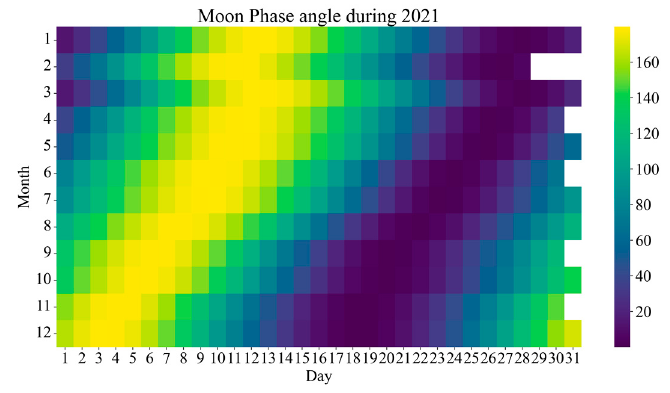
Figure 9. Daily moon phase angle during 2021 .